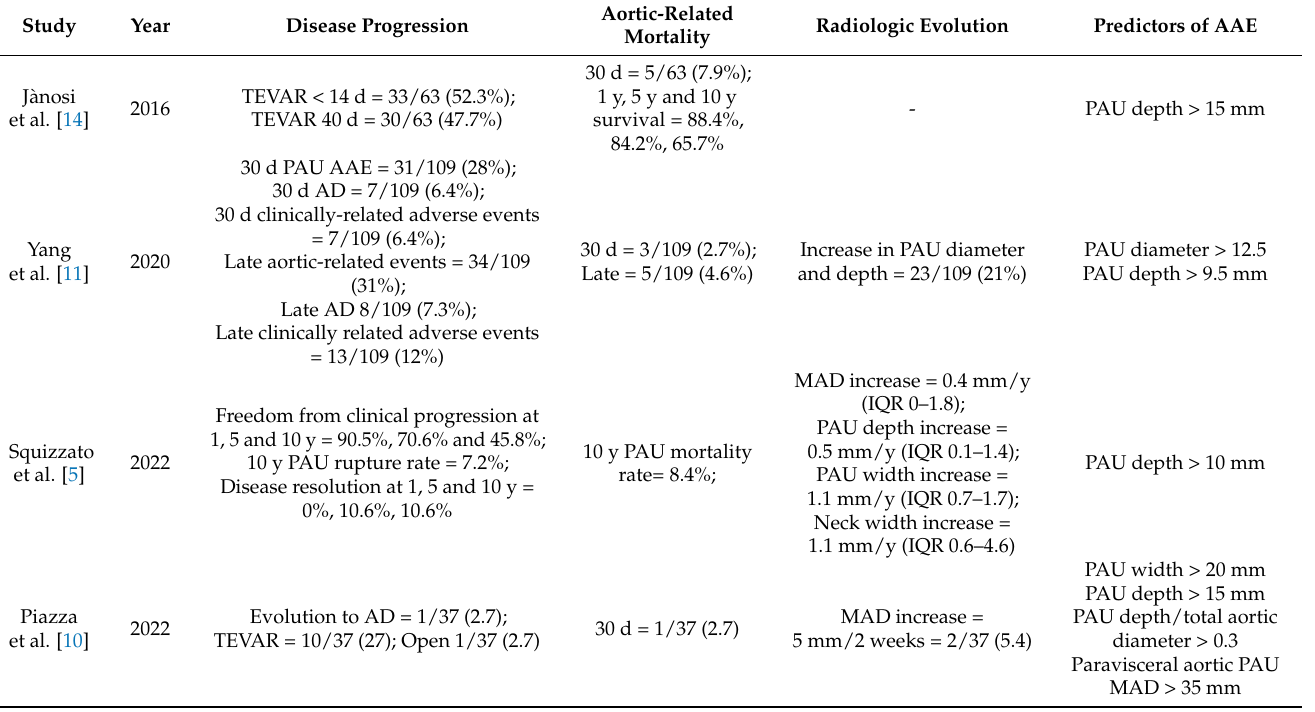
Table 3. Focus on studies reporting on penetrating aortic ulcers (PAU). MAD: maximum aortic diameter; d: days; TEVAR: thoracic endovascular aortic repair; AD: aortic dissection; AAE: aortic- related adverse